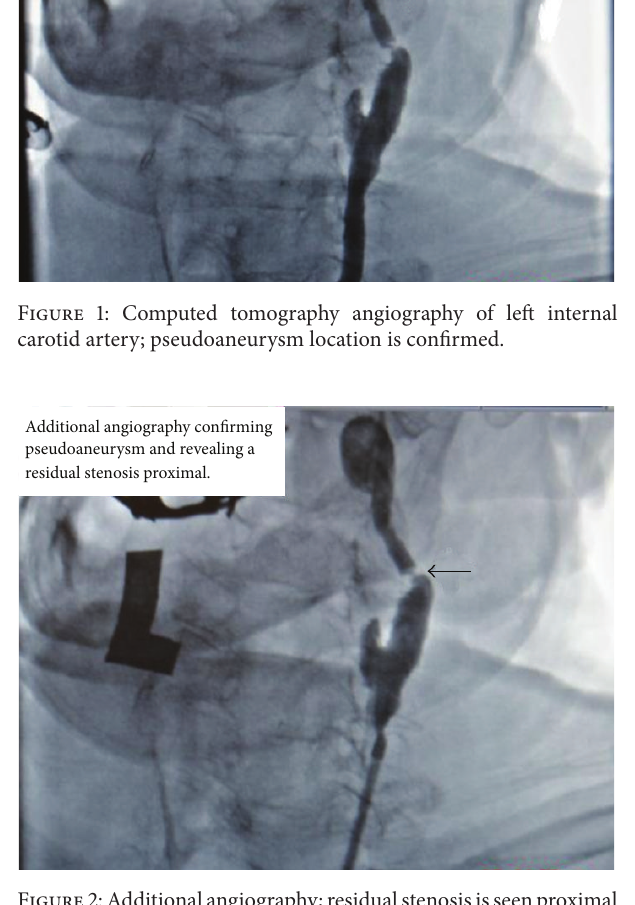
Figure2:Additionalangiography;residualstenosisisseenproximal to the pseudoaneurysm.